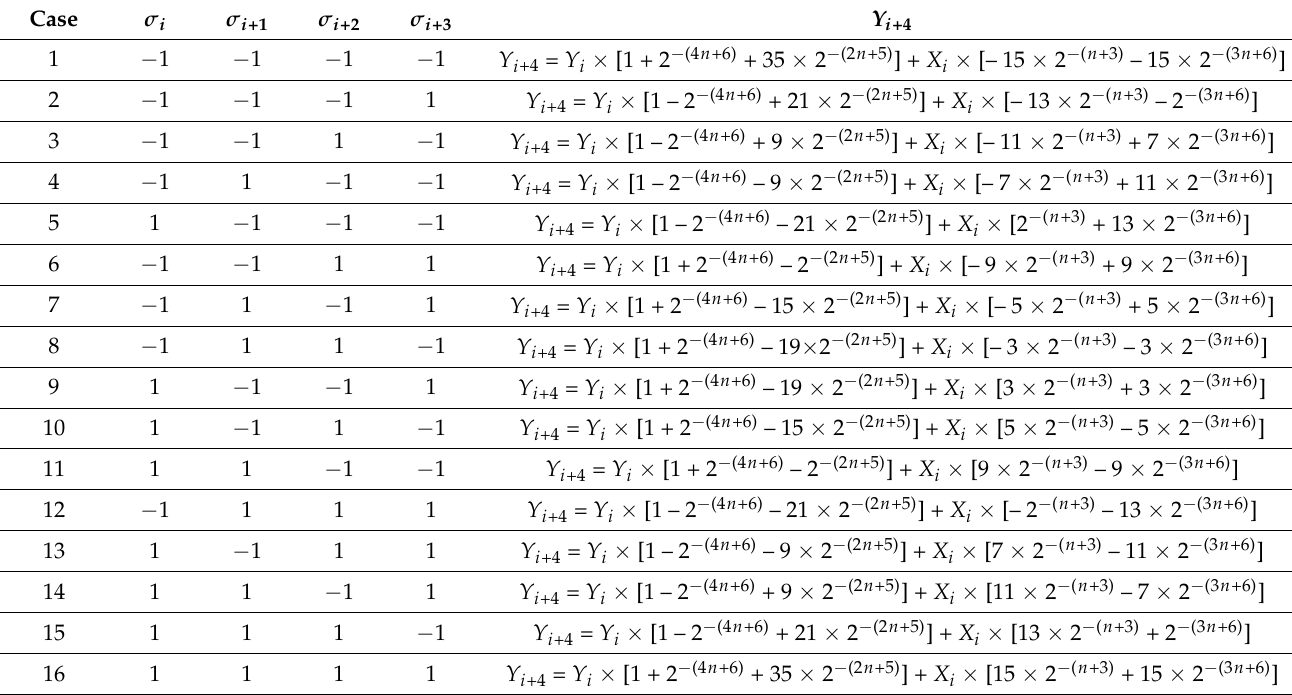
Table 2. Recurrent equations of Y i +4 in QH-CORDIC.